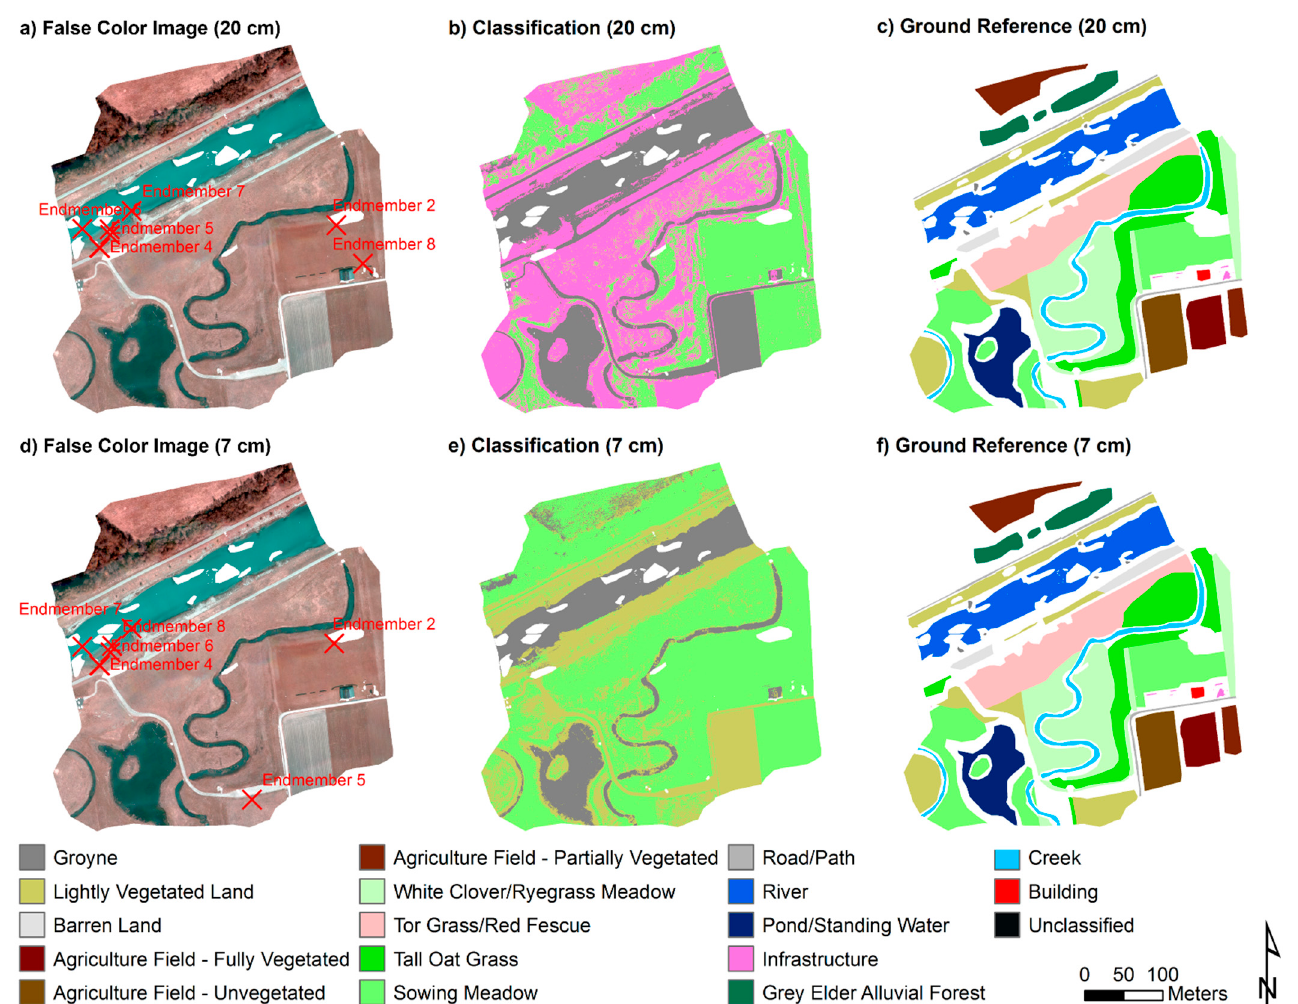
Figure 11. ( a ) Narrow-band image from 11 April 2016 of the River Gail study area with extreme/erroneous pixels masked out at the 20 cm pixel size. The map also shows locations of the identified purest pixels extracted as endmembers and used in the classification; ( b ) Land cover classification generated using the 20 cm narrow-band image, endmembers extracted from ( a ), and the Spectral Angle Mapper algorithm within ENVI; ( c ) Reference data used in assessing the accuracy of the classified image in ( b ); ( d ) Narrow-band image from 11 April 2016 of the River Gail study area with extreme/erroneous pixels masked out at the 7 cm pixel size. The map also shows locations of the identified purest pixels extracted as endmembers and used in the classification; ( e ) Land cover classification generated using the 7 cm narrow-band image, endmembers extracted from ( d ), and the Spectral Angle Mapper algorithm; ( f ) Reference data used in assessing the accuracy of the classified image in ( e ).